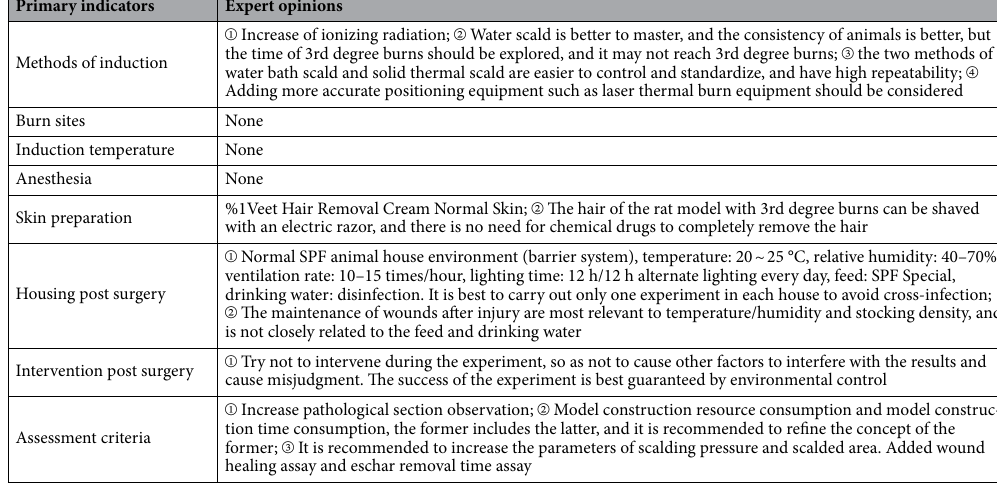
Table 5. Summary of expert opinions after the first round. SPF, specific